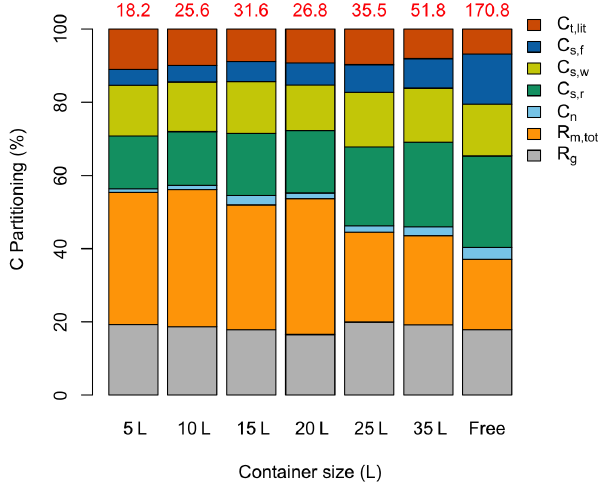
Figure 4. Simulated proportional C partitioning for the whole ex- perimental period. The total accumulated GPP (gCplant − 1 ) for in- dividual treatments is shown (in red) at the top of each column. “Free” stands for free seedling. Different C partitions are in the color legend: total litterfall, C t , lit ; foliage structural C, C s , f ; wood structural C, C s , w ; root structural C, C s , r ; nonstructural C pool, C n ; total maintenance respiration, R m , tot ; and growth respiration, R g .